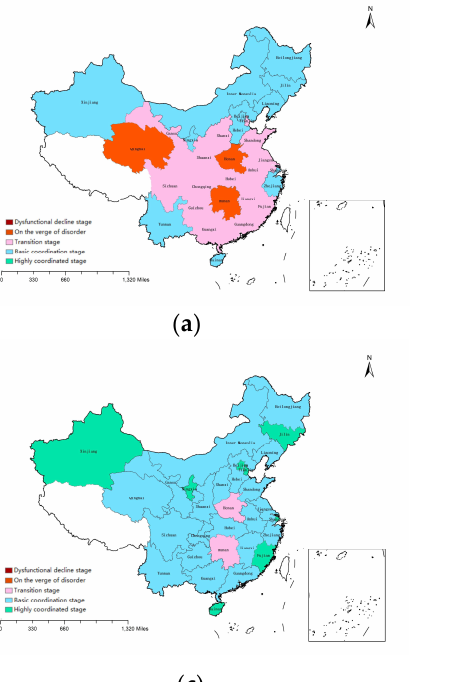
Table 5. Global Moran’s I of coupling coordination degree.